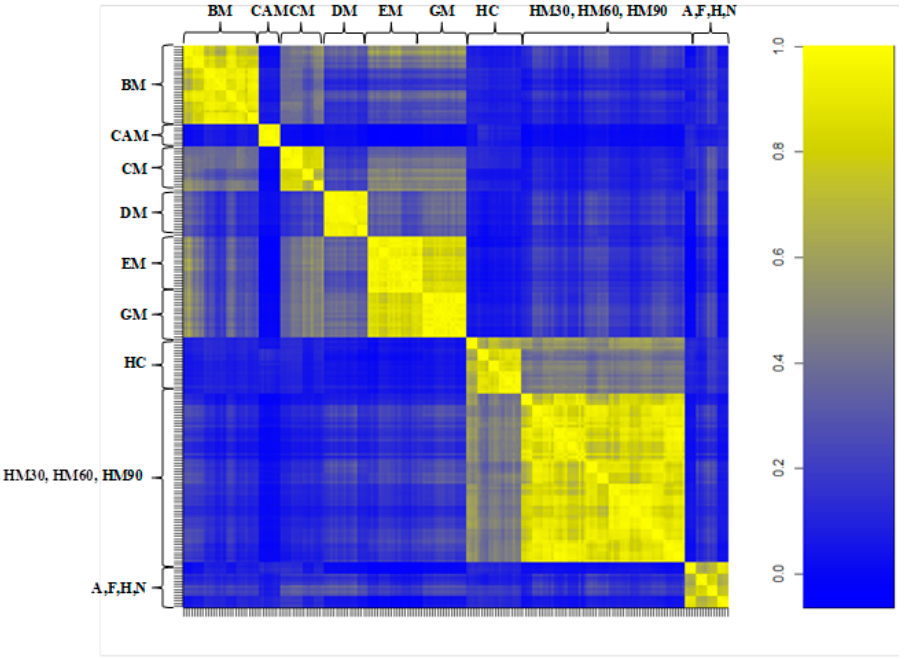
Figure 4. Pearson’s correlation matrix of all spectral replica datasets for animal milk (BM, CAM, CM, DM, EM, and GM), human milk at 2, 30, 60 and 90 days (HC, HM30, HM60 and HM90, respectively), and infant formula (A, F, H, N). Correlation coefficients are represented with decreasing blue and yellow colors according to a scale ranging from 0 to 1, respectively.